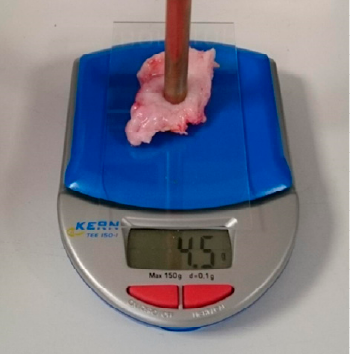
Figure 7. A photo showing cervix tissue-probe contact.